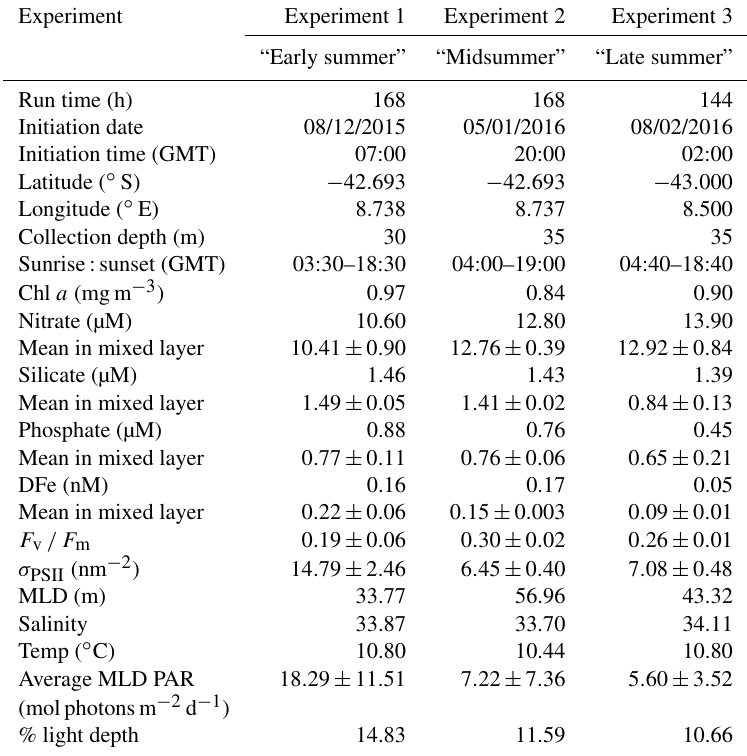
Table 1. Locations of experiments conducted during the cruise along with details of the initial set-up